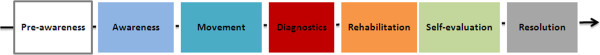
‘Patient journey’ model of adults with gradual-onset acquired hearing impairment[7].